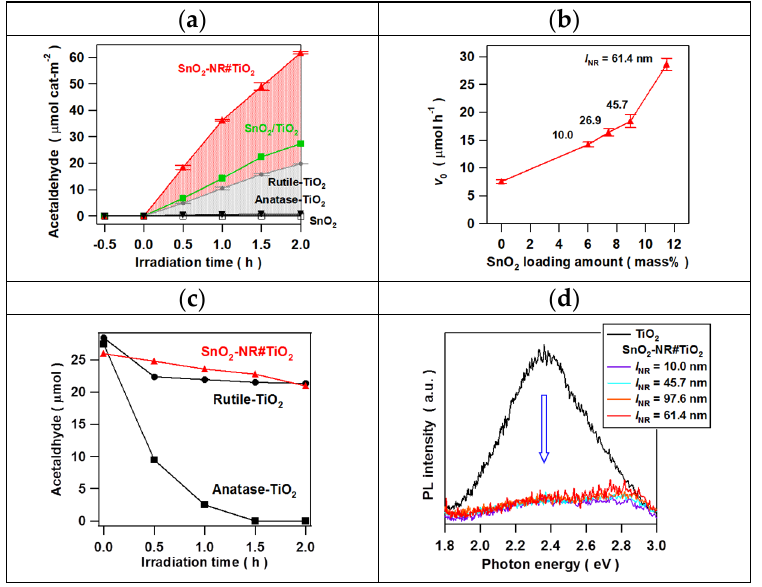
Figure 4. ( a ) Time courses for gas-phase photocatalytic oxidations of ethanol to acetaldehyde under UV-light irradiation ( λ ex > 300 nm). The amount of acetaldehyde is normalized by the specific surface area of the photocatalyst. ( b ) Relation between the photocatalytic activity and SnO 2 loading amount. The corresponding SnO 2 -NR length is shown in the figure. ( c ) Time courses for gas-phase photocatalytic decomposition of acetaldehyde under UV-light irradiation ( λ ex > 300 nm) in the SnO 2 -NR#TiO 2 ( l NR = 61.4 nm) system, and anatase and rutile TiO 2 system for comparison. ( d ) PL spectra for authentic rutile TiO 2 and SnO 2 -NR#TiO 2 with varying mean SnO 2 -NR length under irradiation of light with wavelength of 340 nm at 77 K. The figure is taken from ref. [16]. This value surpasses the values reported for the TiO 2 photocatalytic oxidation of ethanol to acetaldehyde (<~10%) [34,36]. These findings evince the importance of the junction state between SnO 2 and TiO 2 for the activity in the hybrid photocatalyst. Further, the initial photocatalytic activity of SnO 2 -NR#TiO 2 ( v 0 /mol h − 1 ) increases with an increase in x SnO2 (Figure 4b). In addition, there is a clear trend that the photocat- alytic activity increases with increasing l NR . On the other hand, there is linear relations between the amount of acetaldehyde produced and the amount of ethanol consumed in the SnO 2 -NR#TiO 2 and unmodified rutile TiO 2 systems. The selectivity was calculated from the slope in the SnO 2 -NR#TiO 2 ( l NR = 61.4 nm) system to be ~100%. The photocataltyic decomposition of acetaldehyde was further examined with SnO 2 -NR#TiO 2 , anatase and rutile TiO 2 particles. Rutile TiO 2 and SnO 2 -NR#TiO 2 exhibit much lower photocatalytic activity than anatase TiO 2 (Figure 4c). Ethanol oxidation has so far been reported for the photocatalsyts of anatase TiO 2 and P-25 (anatase-rutile mixture). These studies